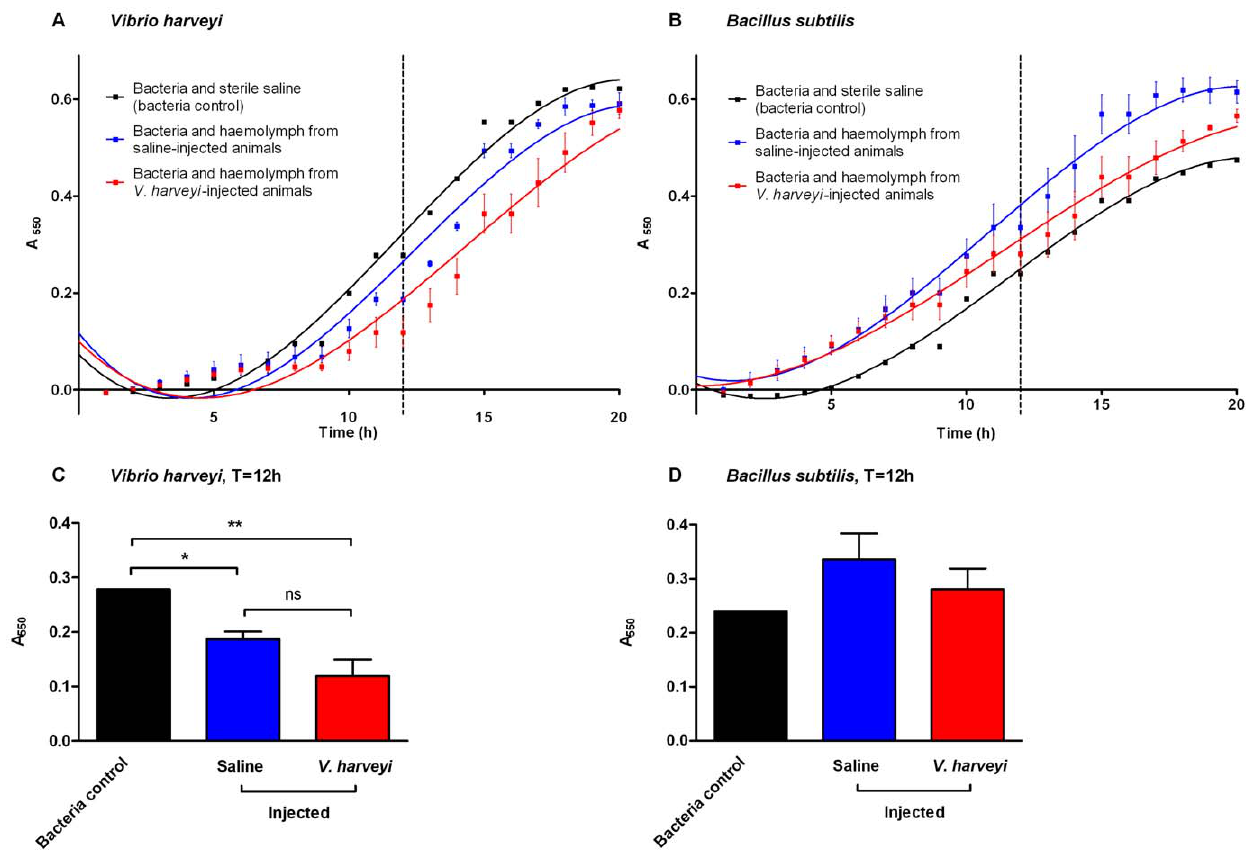
Figure 3. Antibacterial activity of shrimp blood following V. harveyi exposure remains unchanged. Juvenile shrimp ( Litopenaeus vannamei ) were injected with 100 m l of either formalin-inactivated Vibrio harveyi or sterile saline. After 8 d, shrimp haemolymph was added to either V. harveyi or an unrelated, Gram-positive bacterium, Bacillus subtilis . (A) Growth curves for V. harveyi and (B) B. subtilis exposed to shrimp haemolymph from animals injected with either sterile saline or inactivated V. harveyi , or sterile NaCl solution (‘bacteria-only control’ i.e. no haemolymph). Bacterial growth was recorded as absorbance at 550 nm after T=0 had been subtracted. (C) and (D) experimental data from the time (h) closest to the calculated